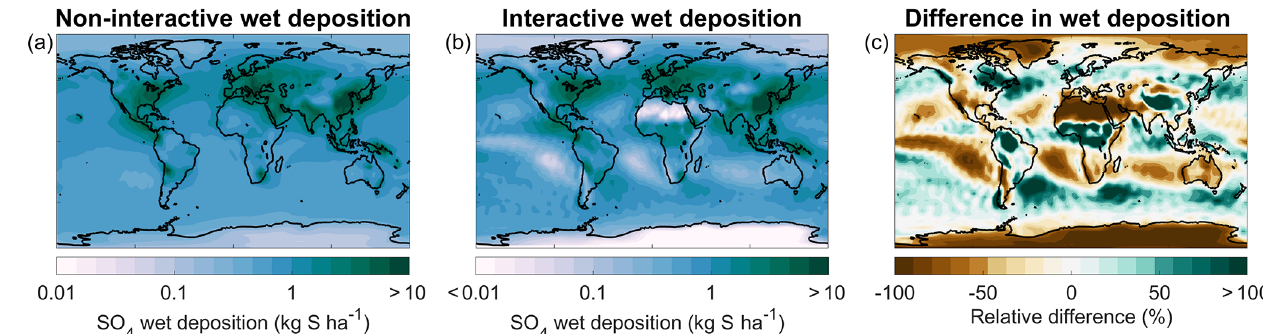
Figure 2. Maps of sulfate wet deposition simulated by SOCOL-AER for the year 2000. Three plots are shown: wet deposition in the DRYDEP simulation, which uses the old wet deposition scheme (a) ; wet deposition in the WETDEP simulation, which uses the interactive wet deposition scheme (b) ; and relative percent differences in deposition, which is WETDEP minus DRYDEP (c)